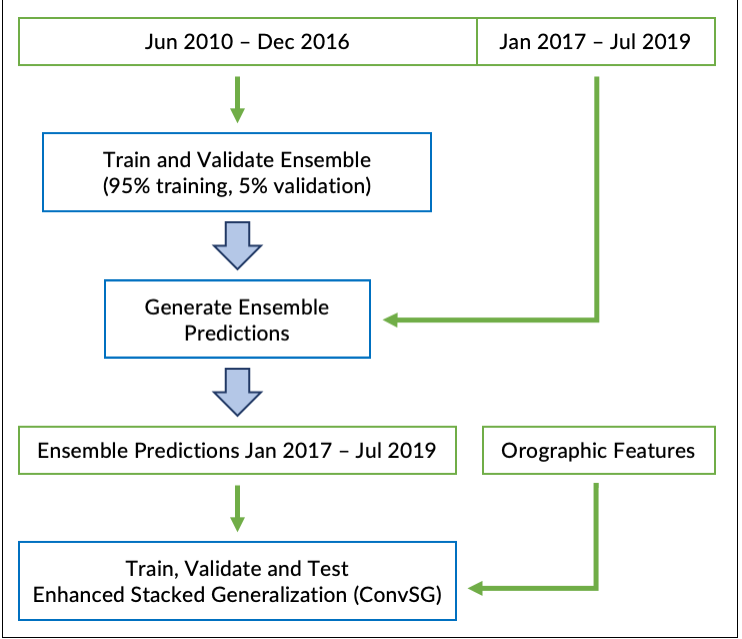
Figure 2. Data architecture of the study. The predictions generated by the ensemble on the test set were used to train, validate and test the stacked